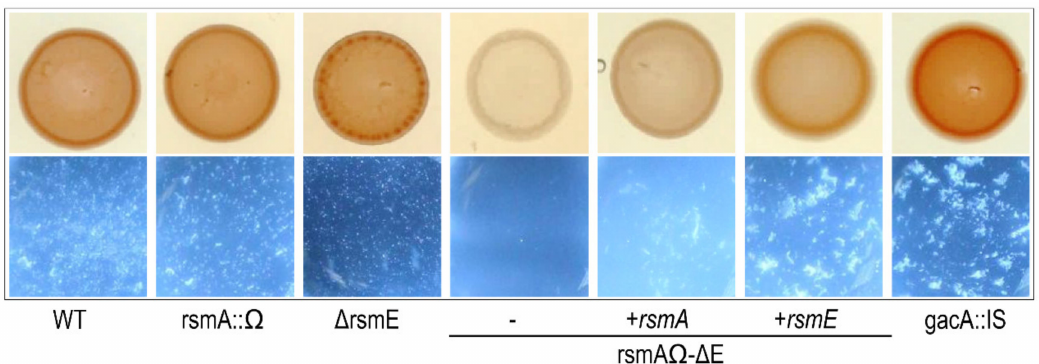
Figure 5. The double mutant rsmA–rsmE does not agglutinate in culture. Hrp-pilus production assay in hrp -induction medium by Congo red staining on plates (top) and autoagglutination in liquid (bottom). Pictures are representative of three independent